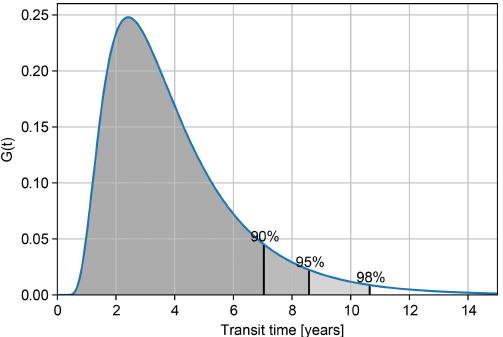
Figure 2. The resulting fit intervals for the fraction of input F = 90%, 95% and 98% are sketched. G(t) is assumed from an inverse Gaussian for (cid:48) = 4 years and (cid:49) 2 = 0 . 7 · (cid:48) .